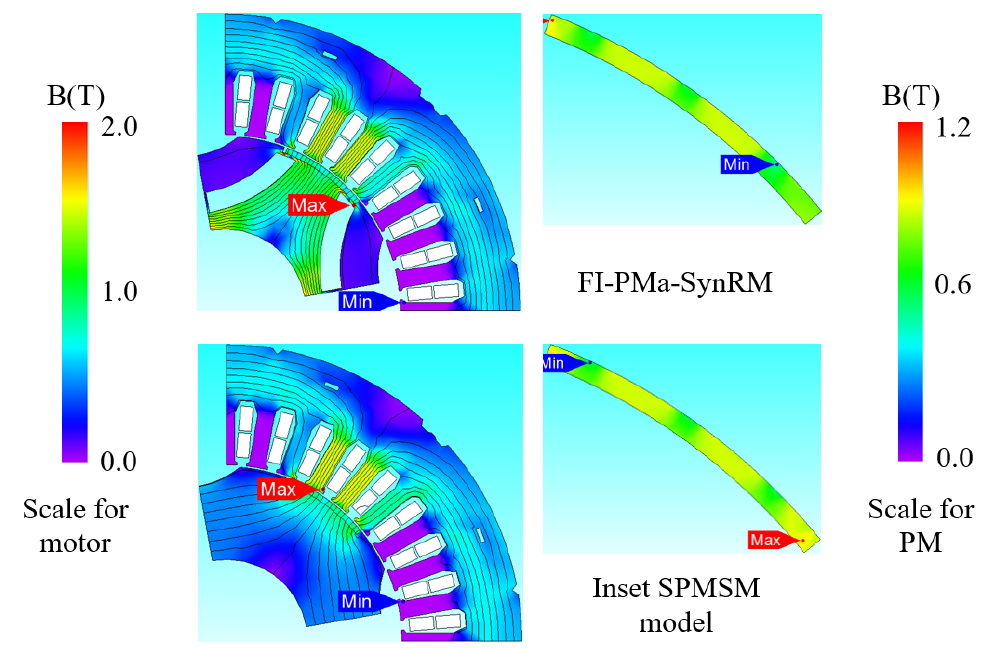
Figure 3. Motor flux densities at no-load conditions. Upper part: FI-PMa-SynRM; lower part: Inset SPMSM.